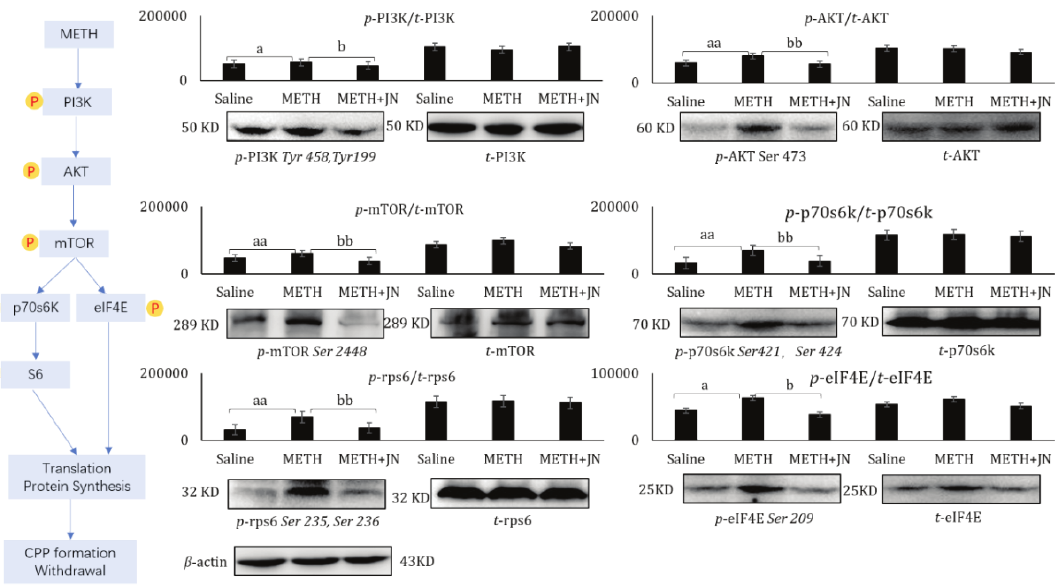
Figure 4: Influence of METH and Jinniu Capsule on the PI3K-AKT-mTOR signaling pathway phosphorylation cascade. Means ± SD, n = 6, a P < 0.05 vs saline group; aa P < 0.01 vs saline group; b P < 0.05 vs METH group; bb P < 0.01 vs METH group. NAc of rats was obtained and the phosphorylation of PI3K, AKT, mTOR, p70s6k, rps6, and eIF4E were